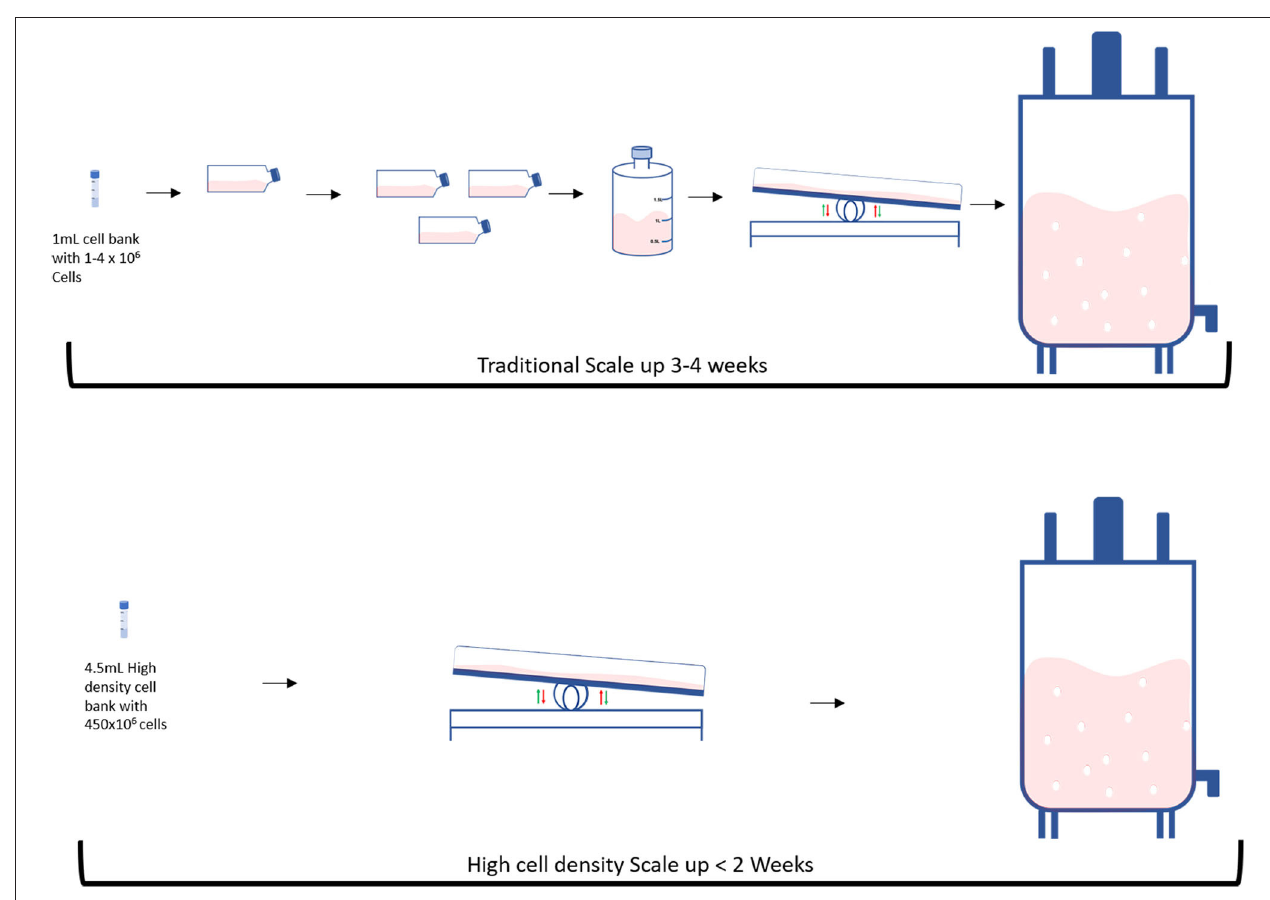
FIGURE 2 | Differences between traditional and High intensity scale up: (Top) Traditional and (Bottom) High intensity